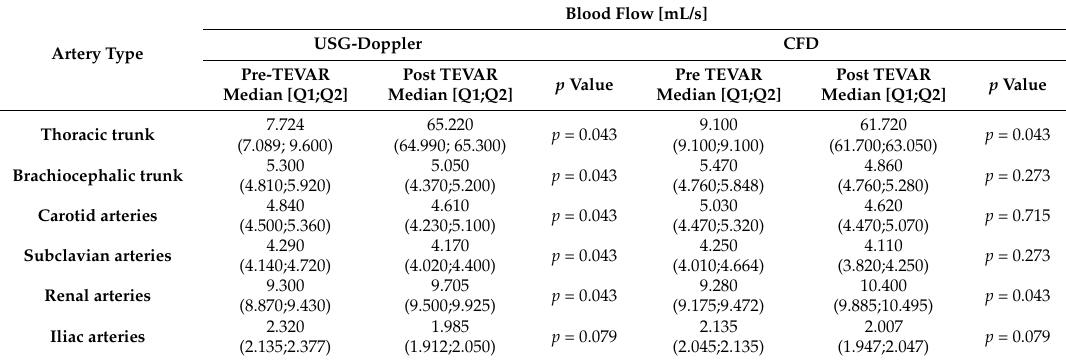
Table 2. Changes in blood flow [mL/s] for pre- and post- thoracic endovascular aortic repair (TEVAR) for ultrasonography (USG-Doppler) and computational fluid dynamics (CFD). Data are presented